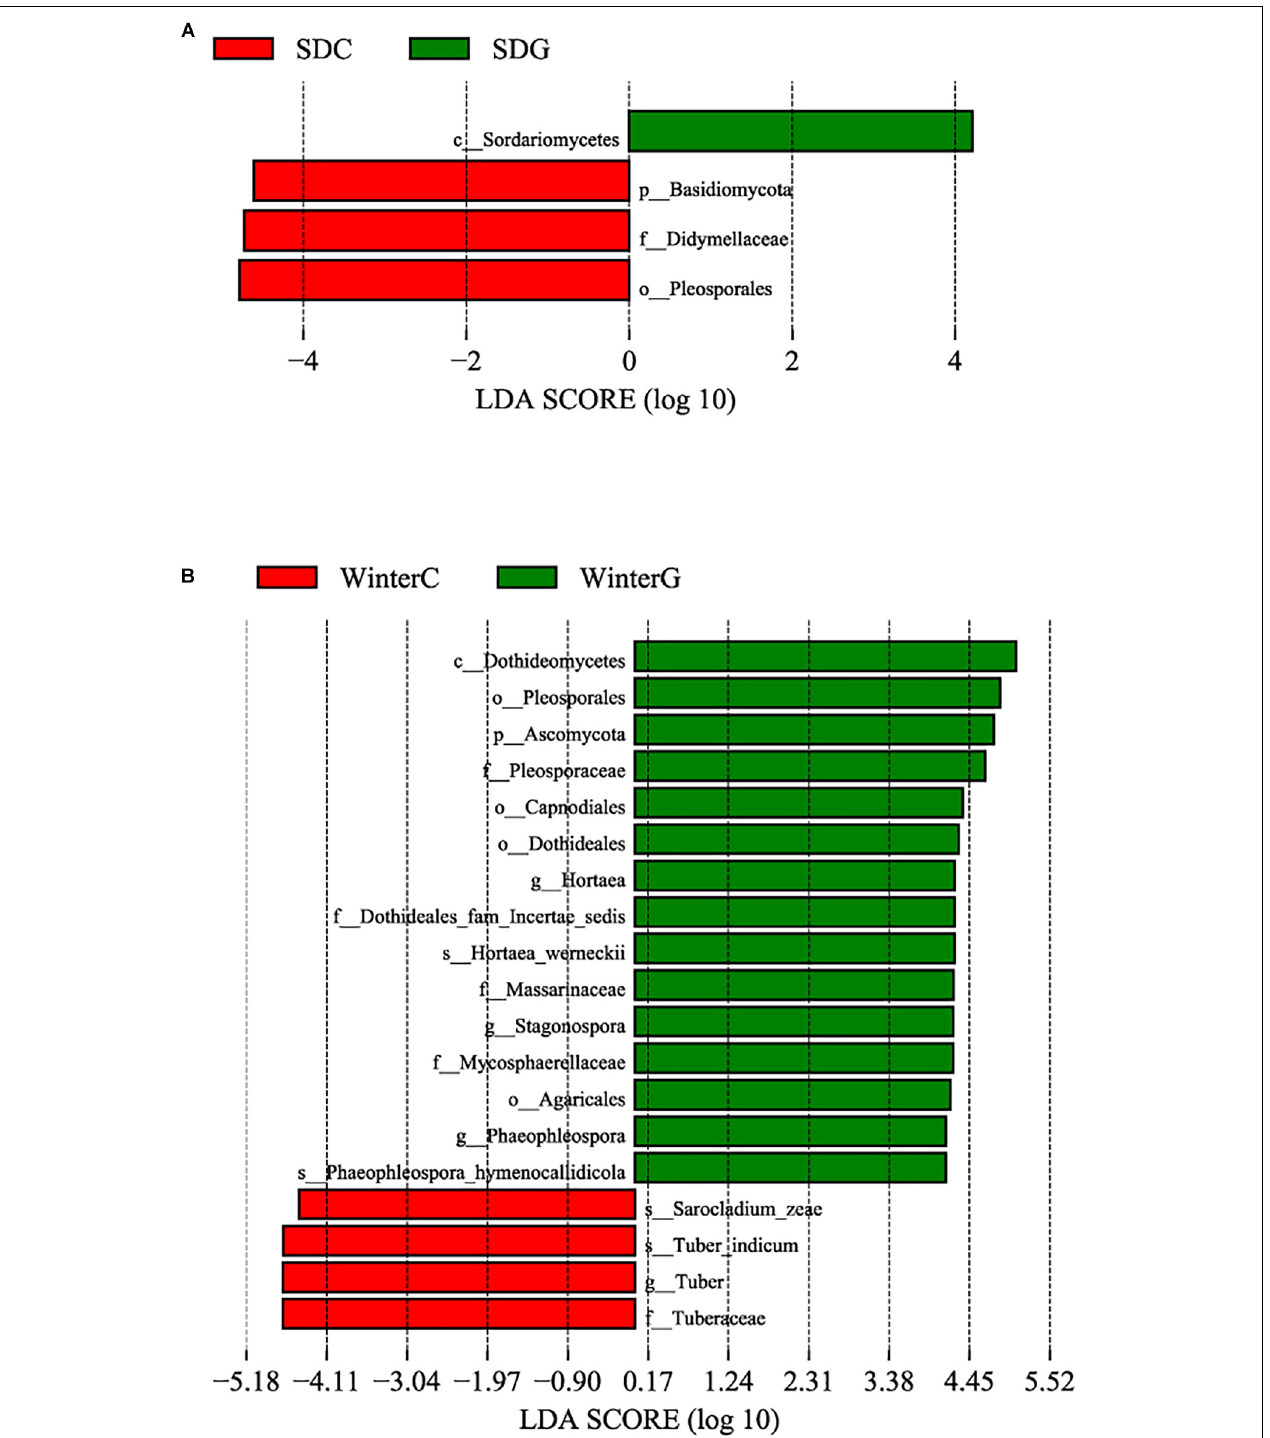
FIGURE 3 | Differences among intestinal and hepatopancreas groups were determined by linear discriminative analysis effect size (LEfSe). The highlighted taxa were significantly enriched in the group that corresponds to each color. LDA scores can be interpreted as the degree of difference in relative abundance. (A) Comparison between the summer healthy intestinal and hepatopancreas samples; (B) comparison between the winter intestinal and hepatopancreas samples. p_, phylum, c_class, o_order, f_, family, g_, genus and s_, species; WinterC, winter intestinal group; WinterG, winter hepatopancreas.